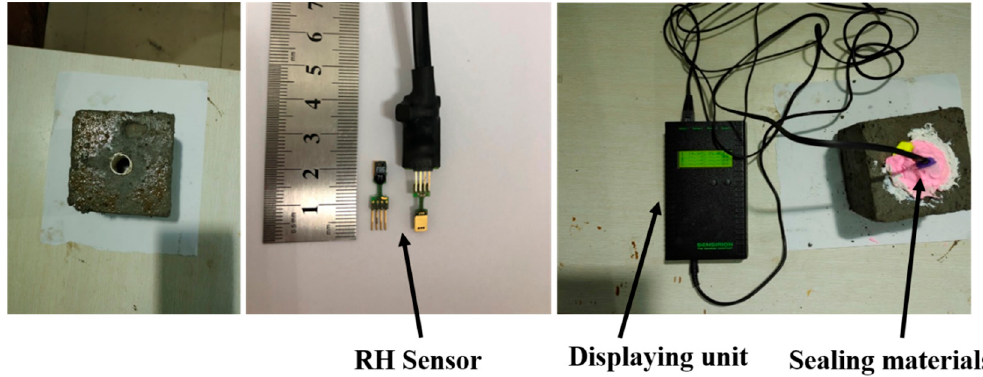
Figure 5. Internal relative humidity (RH) test setup.